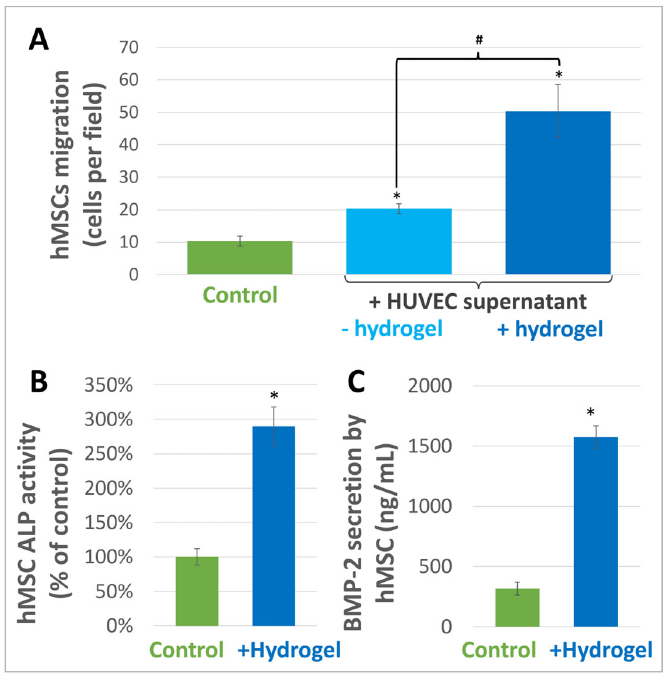
Figure 8. ( A ) Effect of the hydrogel on hMSC migration. Migration of hMSCs significantly increased when they were incubated with HUVEC supernatants in Boyden chambers for 24 h. The increase was significant whether HUVECs were incubated with or without the hydrogel as compared to the control. However, this increase was significantly higher with the hydrogel. Results are expressed as number of cells per field. * indicates a significant difference with the control. # indicates a statistical difference between the two stimulation conditions (+/ − hydrogel) ( p < 0.05). ( B ) hMSC osteogenic differentiation. Incubating hMSCs with the hydrogel for 7 days significantly increased their alkaline phosphatase activity. Results are expressed in percentage of the control. * indicates a statistical dif ‐ ference with the control ( p < 0.05). ( C ) BMP ‐ 2 secretion by hMSCs. After incubating hMSCs with the hydrogel for 72 h, a significant increase in BMP ‐ 2 secretion was observed as compared to the control. Results are expressed in ng/mL. * indicates a statistical difference with the control ( p < 0.05).